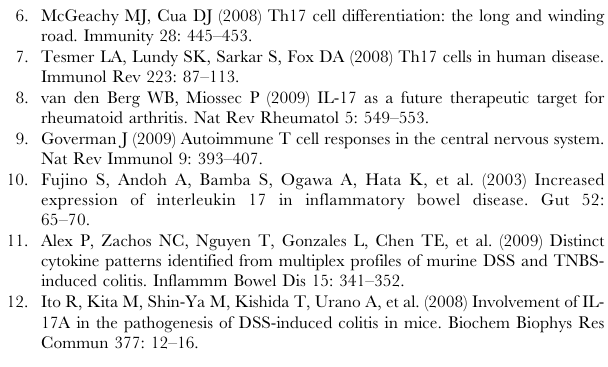
Figure S1 The change in body weight was not affected with daily administration of W-061 (3 mg/kg). Data represent absolute values (means 6 SD, n= 6). (TIF)